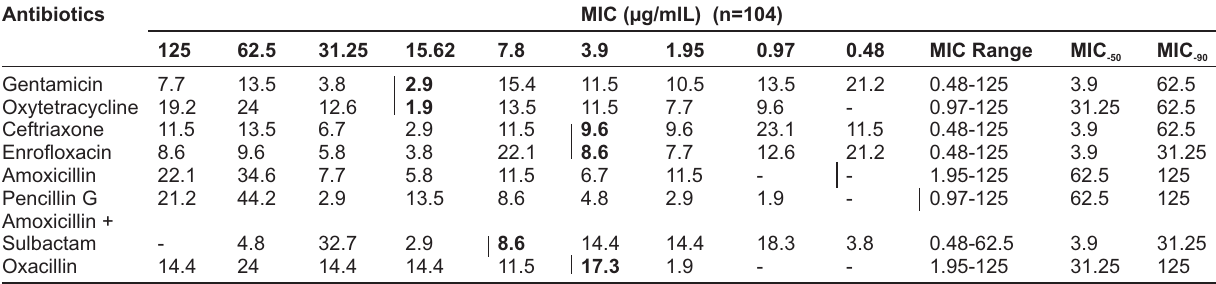
Table-3: MIC of drugs against (n=104) isolated from udder of cows S.aureus Antibiotics